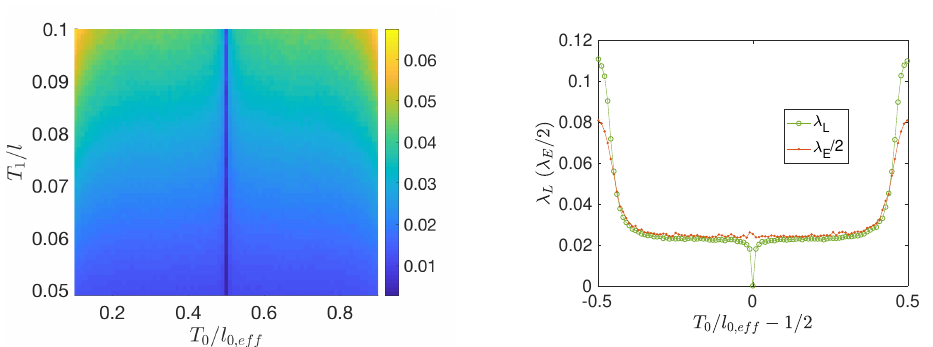
Figure 27: Left: Distribution of Lyapunov exponents λ . We drive the CFT randomly L with H and H . For H , we choose σ 0 = σ − = 0 and σ + = 1 in (5). For H we 0 1 1 0 = p = 1 / 2. See choose σ + = σ − = 0 and σ 0 = 1 in (5). The probabilities are p 0 1 = 5 × 10 3 . also (B.7) for the schematic plot of the phase diagram. We take N sample / 2 along T / l = 0.07 in the left plot. λ Right: Comparison of λ and λ are obtained L E E 1 = 5 × 10 4 by taking N sample